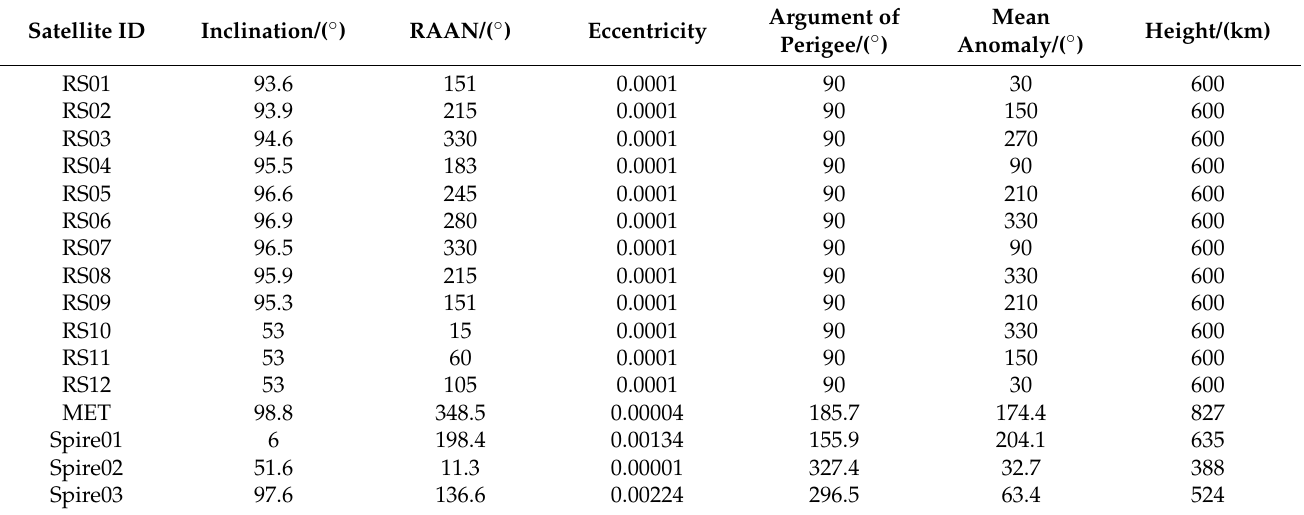
Table 2. Main orbital elements of the receiving